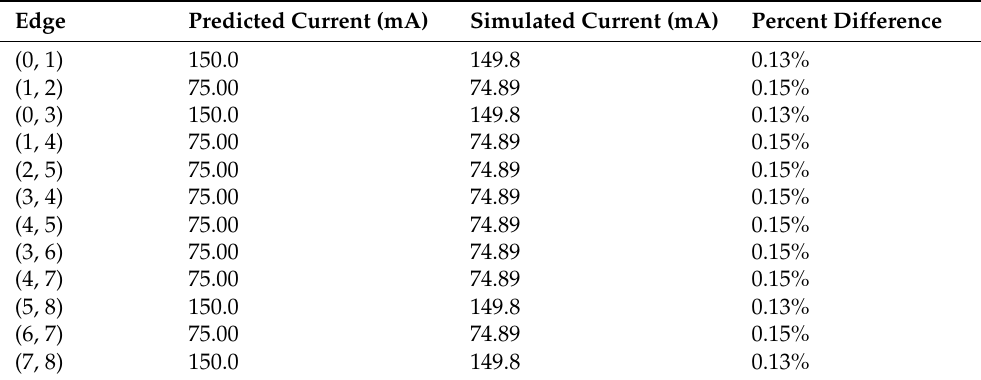
Table 2. Theoretical and simulated currents on each edge for the control strategy represented by blue shown in Figure 12.